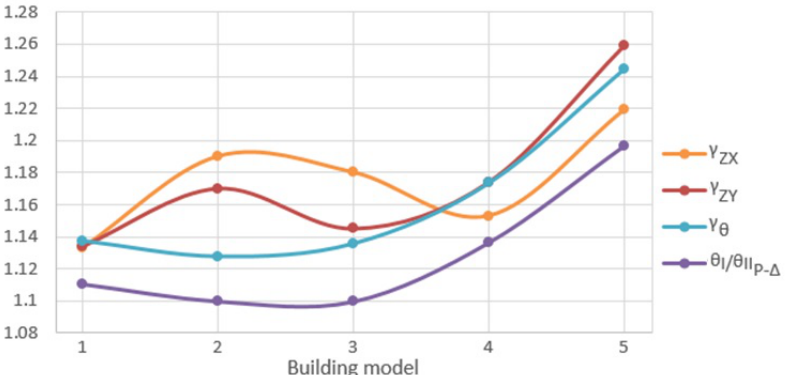
Figure 11. Comparison on the parameters behavior (second